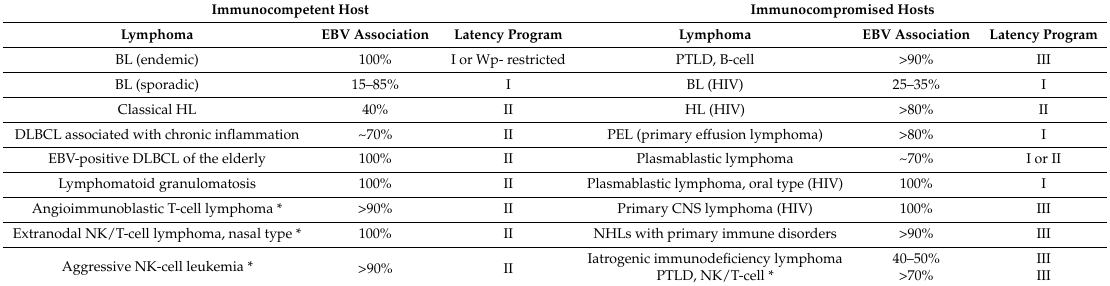
(Table 1). It is also found in 100% of non-keratinizing nasopharyngeal carcinomas and has been linked sporadically to cancers of the gastrointestinal tract [4,5]. Table 1. Epstein–Barr (EBV)-associated lymphomas in immunocompetent and immunocompromised hosts.